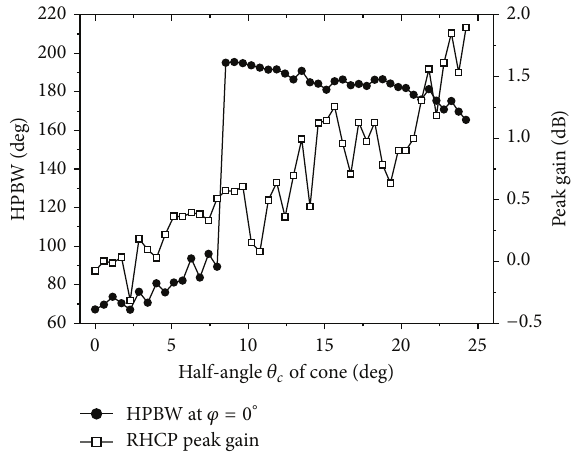
Figure 3: HPBW, peak gain versus half-angle 𝜃 𝑐 of cone.